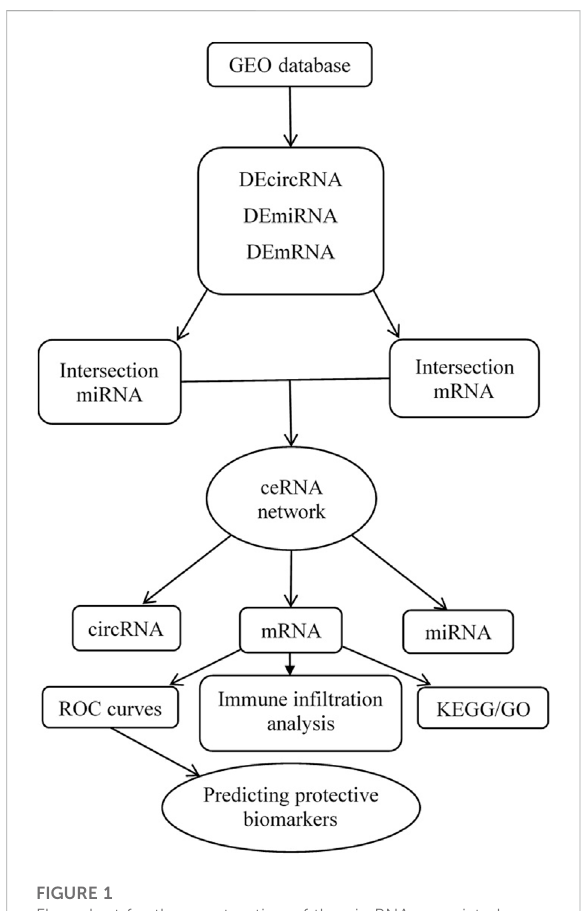
FIGURE 1 Flow chart for the construction of the circRNA-associated ceRNA regulatory network and analysis of the hub